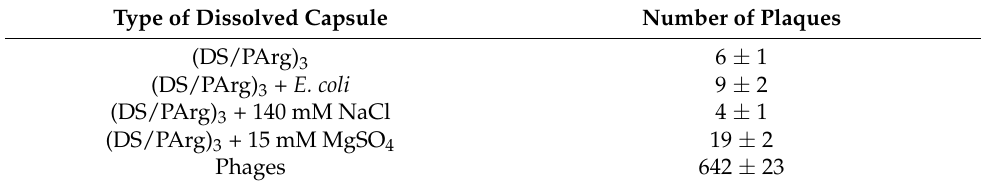
Table 2. Influence of dissolved capsules on